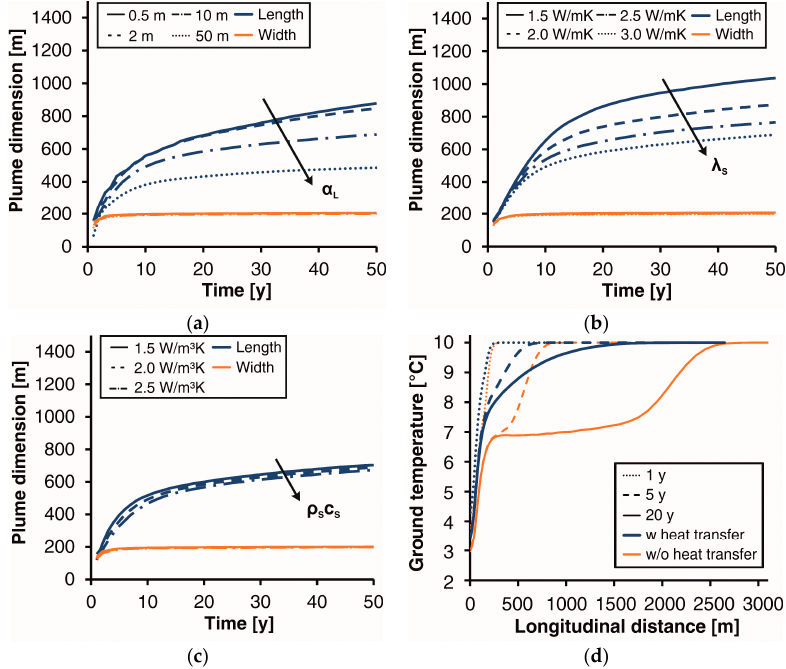
Figure 7. Time evolution of plume dimensions with different values of longitudinal thermal dispersivity α L ( a ); solid matrix thermal conductivity λ s ( b ); and thermal capacity ρ s c s ( c ); longitudinal temperature profile downstream of the reinjection well with and without considering heat exchange with unsaturated layers, for the default simulation and at different times ( d ); isotherm ∆ T = 1 °C.